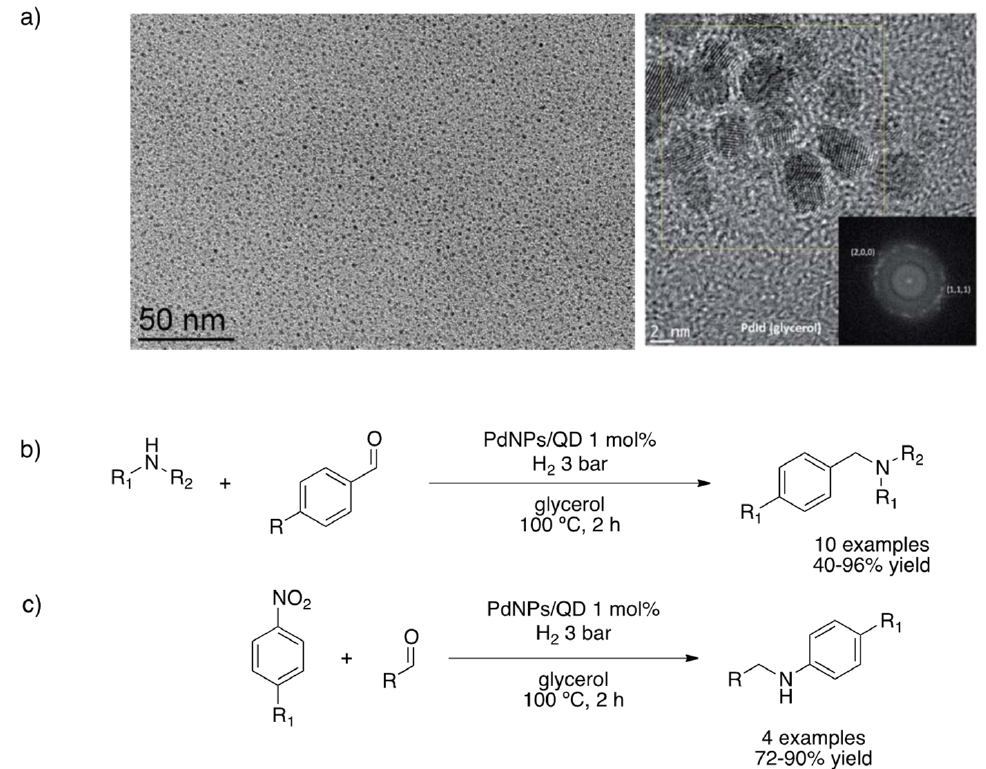
Figure 8. TEM (top left) and HR-TEM (top right) images of PdNPs stabilized with quinidine in glycerol ( a ). Synthesis of secondary amines ( b ) and N -substituted anilines ( c ) under hydrogen pressure catalyzed by PdNPs/QD in glycerol [114]. Reproduced from [114] with permission from the Royal Society of Chemistry.